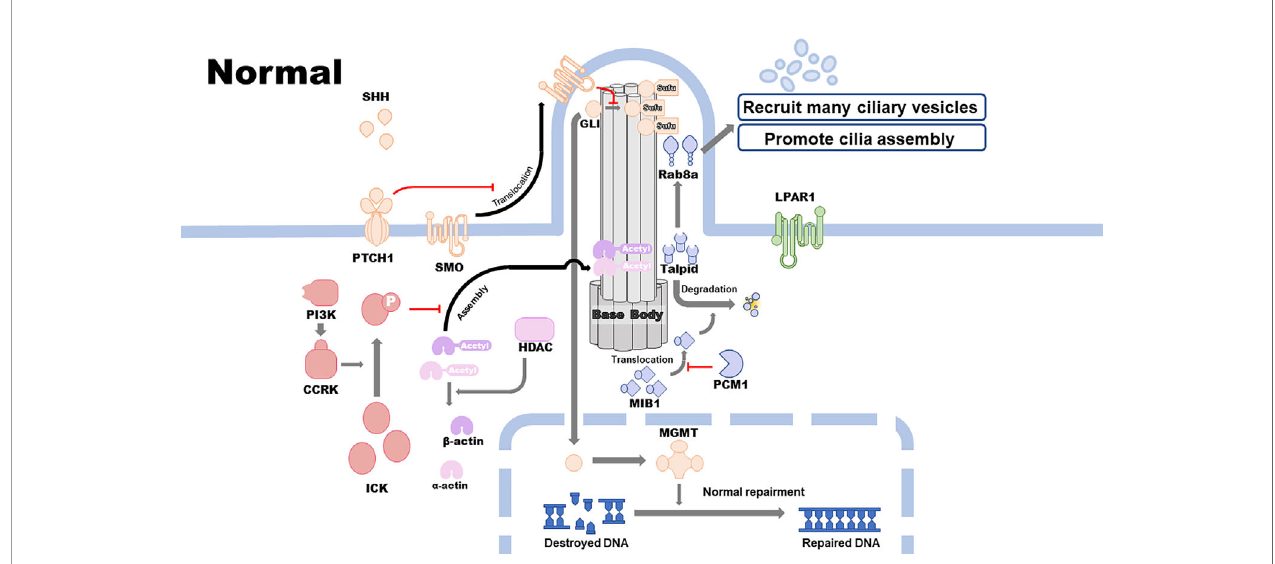
FIGURE 1 | Cilia-related pathways in normal